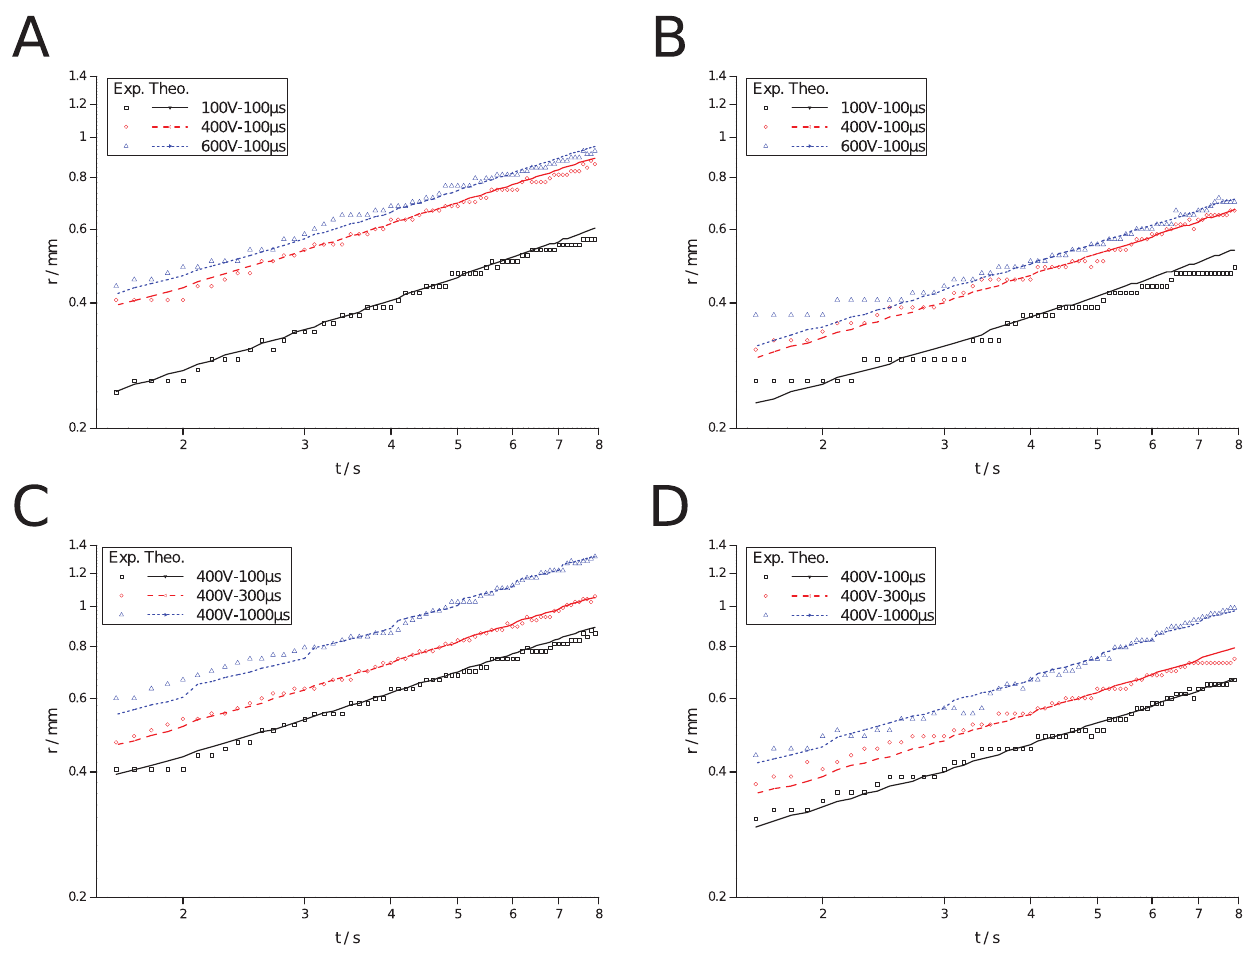
Figure 3. pH front tracking during an ECT, measured (symbols) and predicted (lines), in semi-log scale. a) Anodic front, pulse length of 100 m s , 8 pulses, 1 Hz and pulse amplitudes of 100 V , 400 V and 600 V . b) Cathodic front, same parameters as in a). c) Anodic front, pulse amplitude of 400 V , 8 pulses, 1 Hz and pulse lengths of 100 m s , 300 m s and 1000 m s . d) Cathodic front, same parameters as in c).